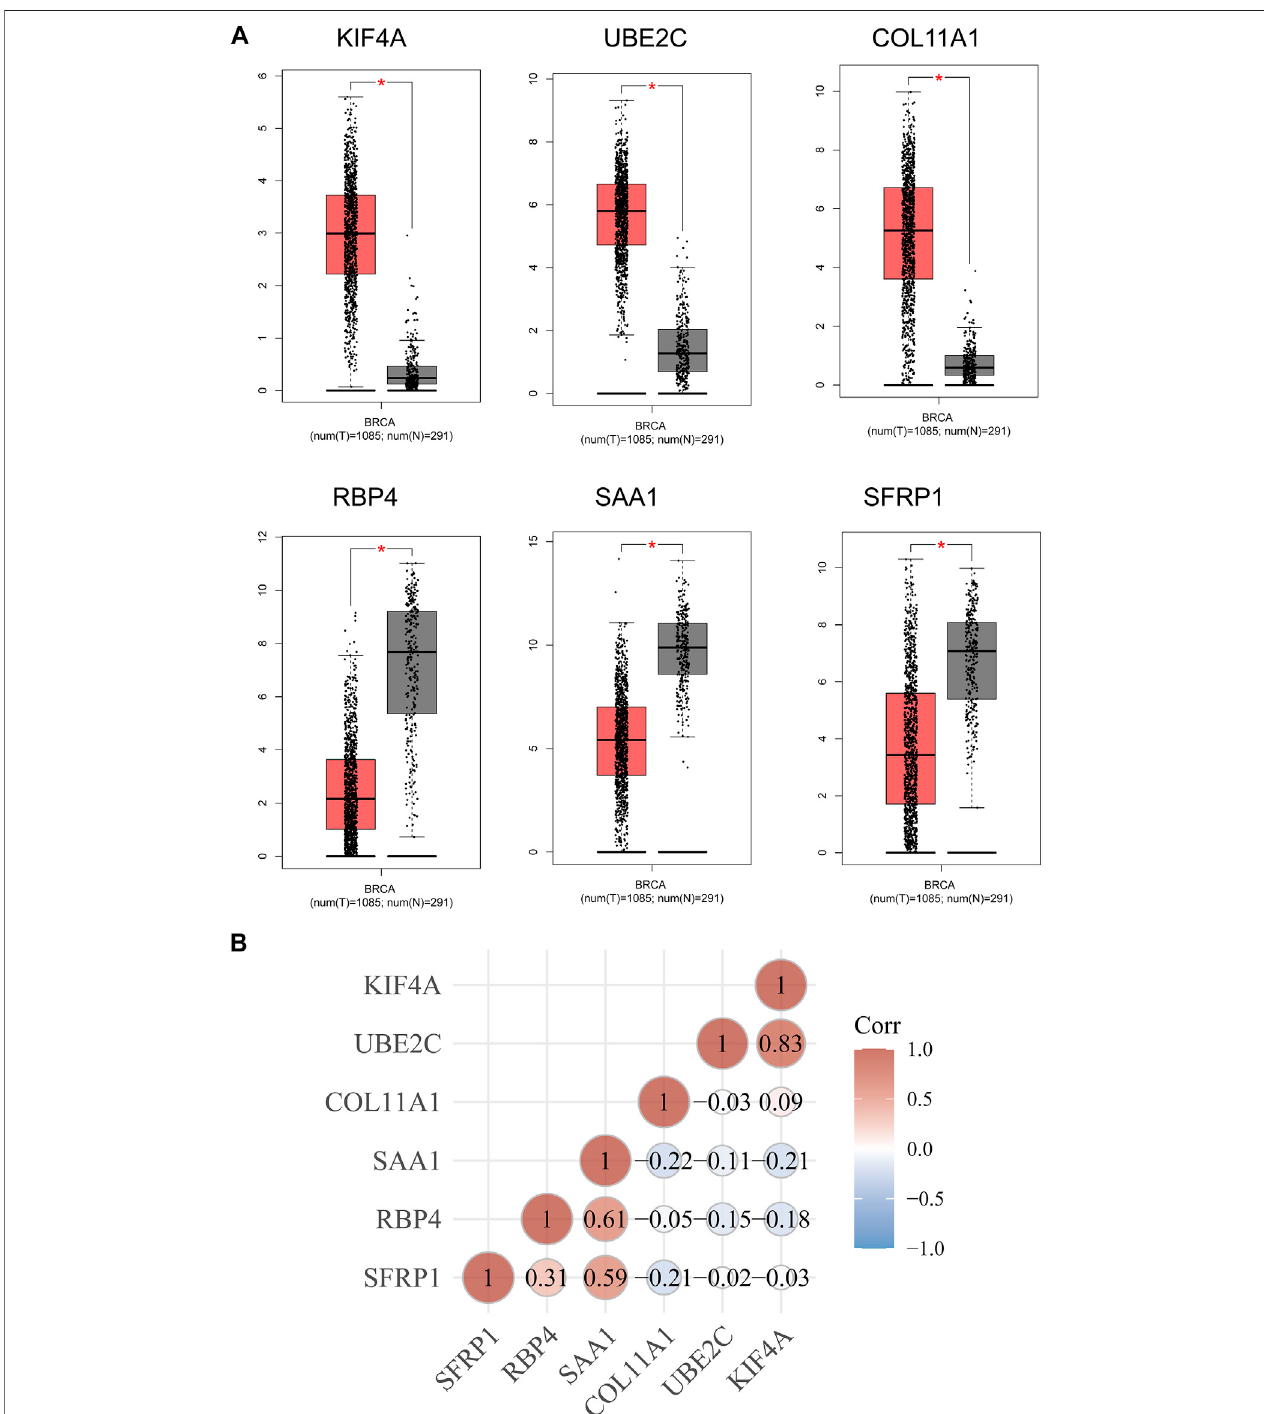
FIGURE 4 | (A) The expression of the six survival-related genes in BC specimens and normal breast cancer specimens from TCGA and GTEx data. (B) The associations between the expressions of the six survival-related genes.